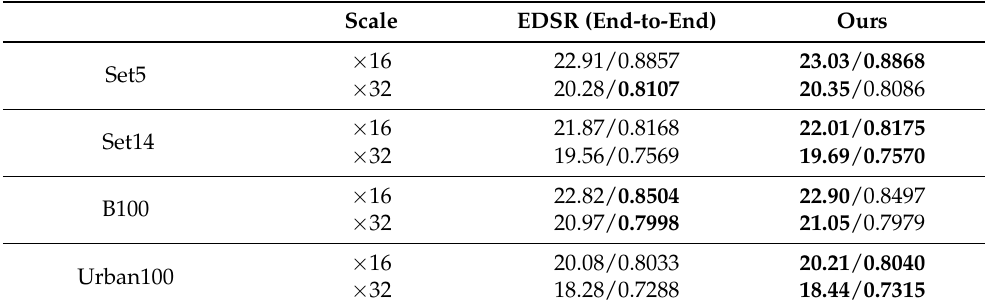
Table 3. PSNR and SSIM values of reconstruction results by high-magnification super-resolution end-to-end method and different model cascade